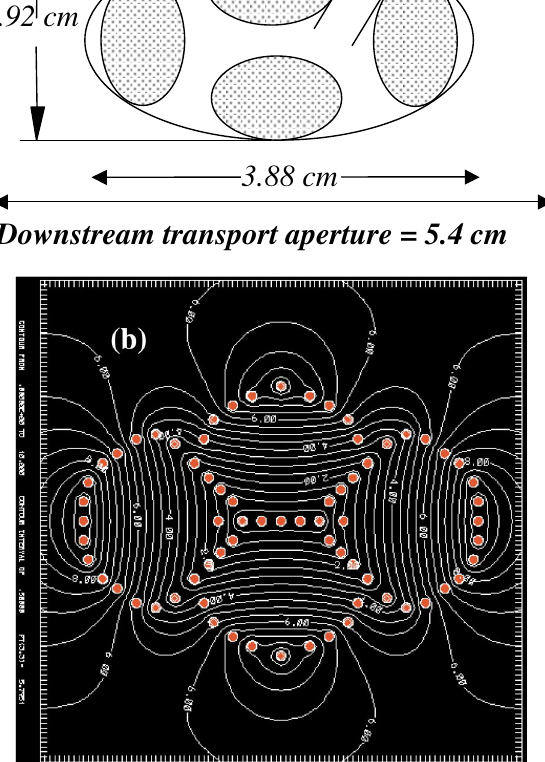
FIG. 2. (Color) (a) Schematic of the beam footprints at the exit of QD 5 . The individual beam semimajor and semiminor axes are 6.5 and 3.7 mm. The beam edge to beam-edge clearance is (cid:22) (cid:5) 4 mm . The upstream matching solution is chosen so that the beam envelope divergence angles are zero ( a 0 (cid:5) b 0 (cid:5) 0 ) at this point, which also helps to minimize phase space dilution of the merged beam. (b) The dipole component is apparent from the equipotentials (calculated in a 2D approximation) of the merge element due to the voltages on the rods of QD 5